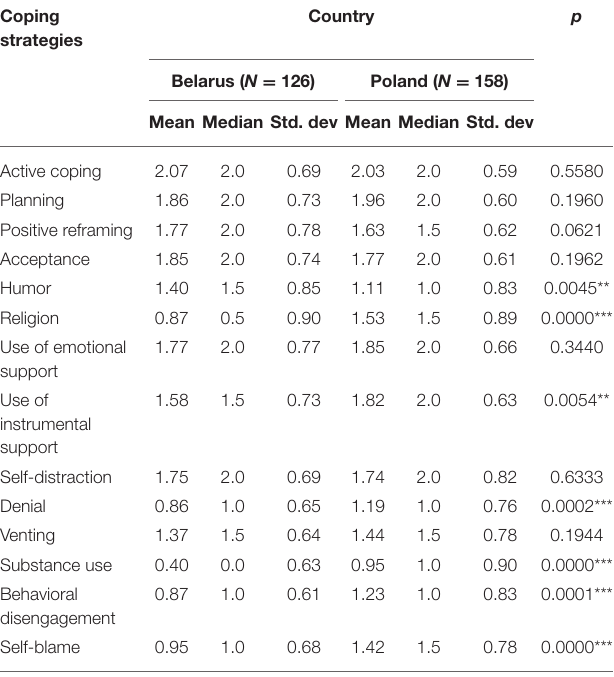
TABLE 2 | Descriptive statistics for measures of coping strategies among nurses. Coping strategies